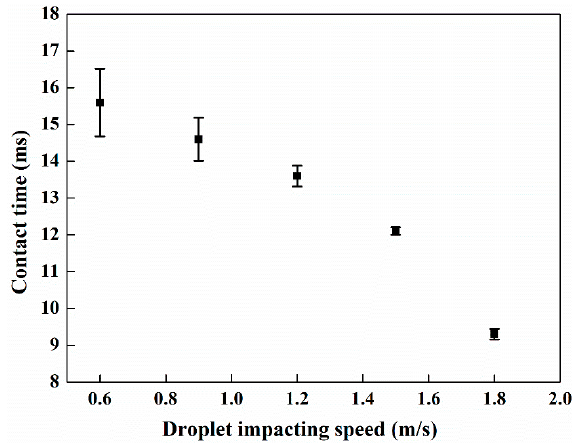
Figure 9. The contact time of droplet on the cold elastic membrane surfaces at different impacting speed.